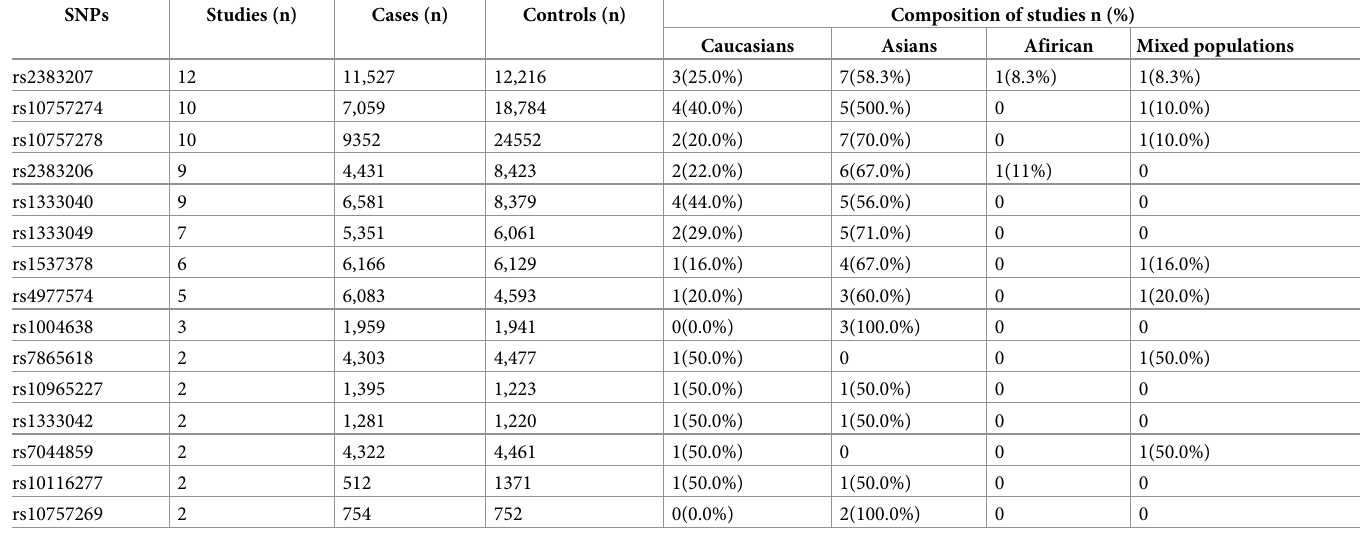
Table 2. ANRIL SNPs included in the meta-analysis.